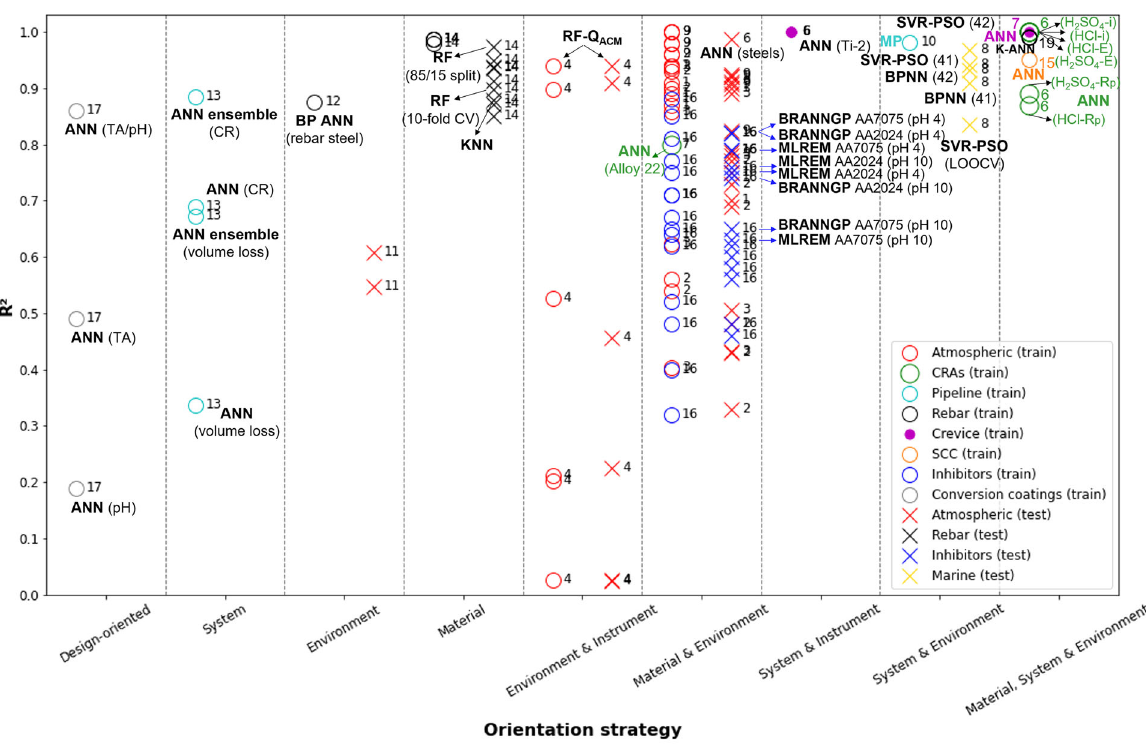
Fig. 5 Performance of the ML models expressed by the R² (refs. 1 – 4,6 – 17,19 ), segmented by ‘ Corrosion topic ’ and organised by ‘ Orientation strategy ’ . R² values are distinguished for training ( ‘ O ’ ) and testing ( ‘ X ’ ) performances. The models ’ names of data points referred to in the text were included next to the respective ‘ X ’ points (other useful descriptors were also included whenever